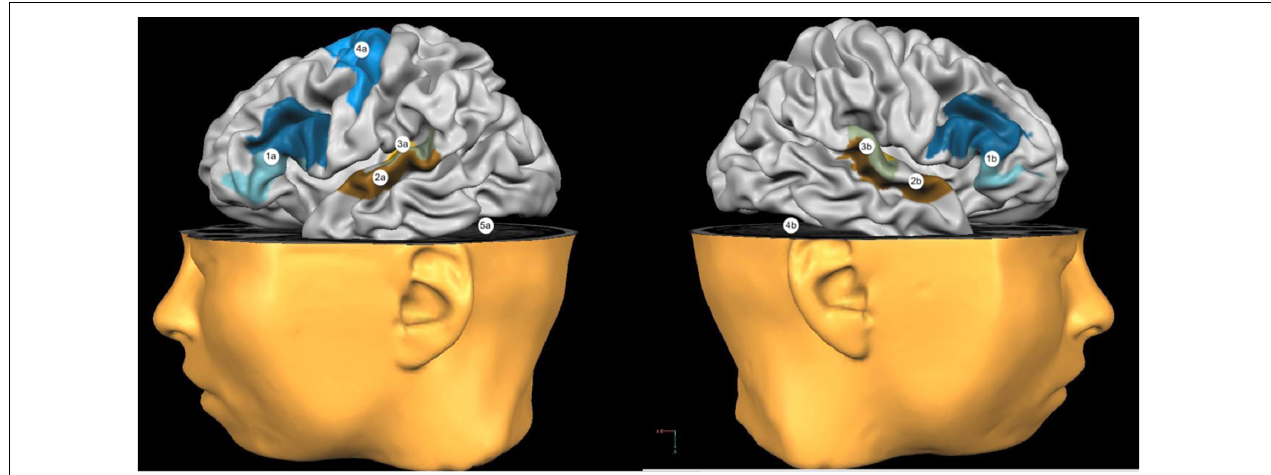
FIGURE 2 | Most used stimulation sites. 1a: Broca’s Area; 2a: Wernicke’s Area; 3a: Left Temporoparietal Cortex; 4a: Left Primary Motor Cortex; 5a: Left Cerebellar Hemisphere. 1b: Right Broca’s Homologous Areas; 2b: Right Wernicke’s Homologous Areas; 3b: Right Temporoparietal Cortex; 4b: Right Cerebellar